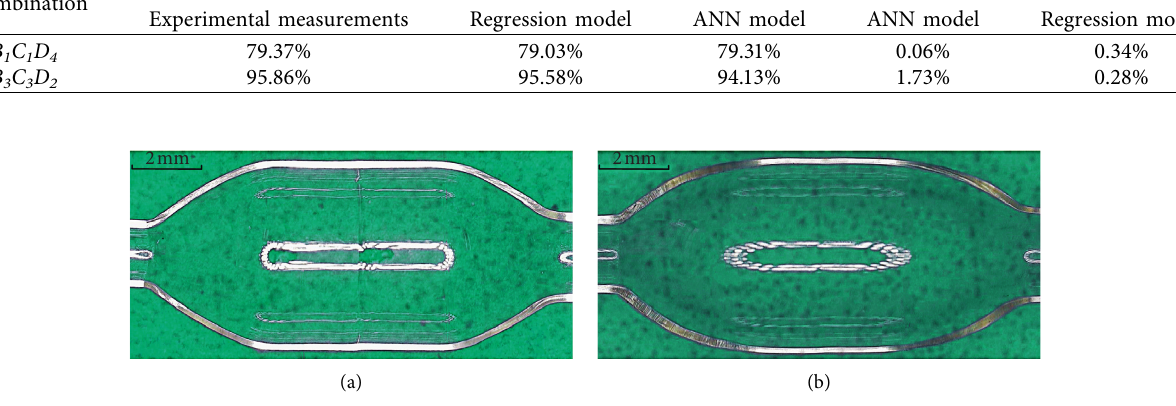
Figure 7: Cross-sectional picture of balloon: (a) optimal balloon and (b) poor